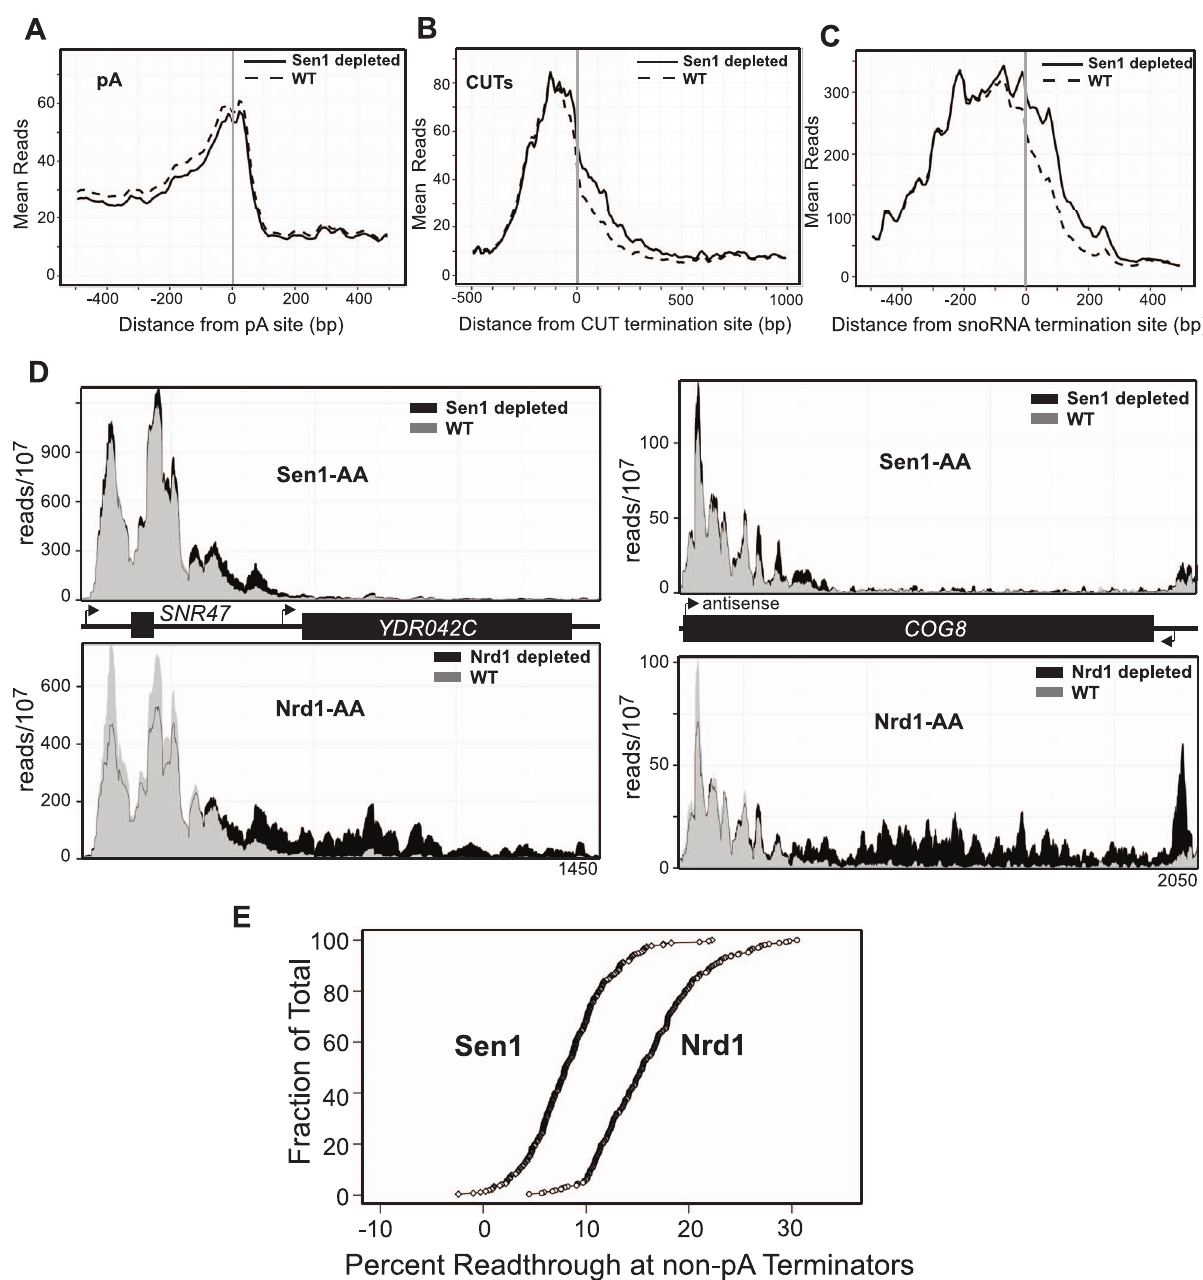
Figure 6. Sen1 depletion causes readthrough at non-pA terminators. A.–C. Mean reads every 10 bp for the top 500 polyA,144 calculated CUT termination sites, and 49 snoRNA termination sites, with Sen1 (dotted) and without Sen1 (solid). D. Histograms representing normalized reads with Sen1 (grey) and without Sen1 (black) at the given genomic locations. The same region is also represented in as a histogram below each graph with Nrd1 (grey) and without Nrd1 (black). E. Percent readthrough of non-pA terminators (ordered from highest to lowest) represented as a fraction of the total number of calculated non-pA terminators. SEN1-FRB is represented as diamonds and NRD1-FRB is represented as circles.